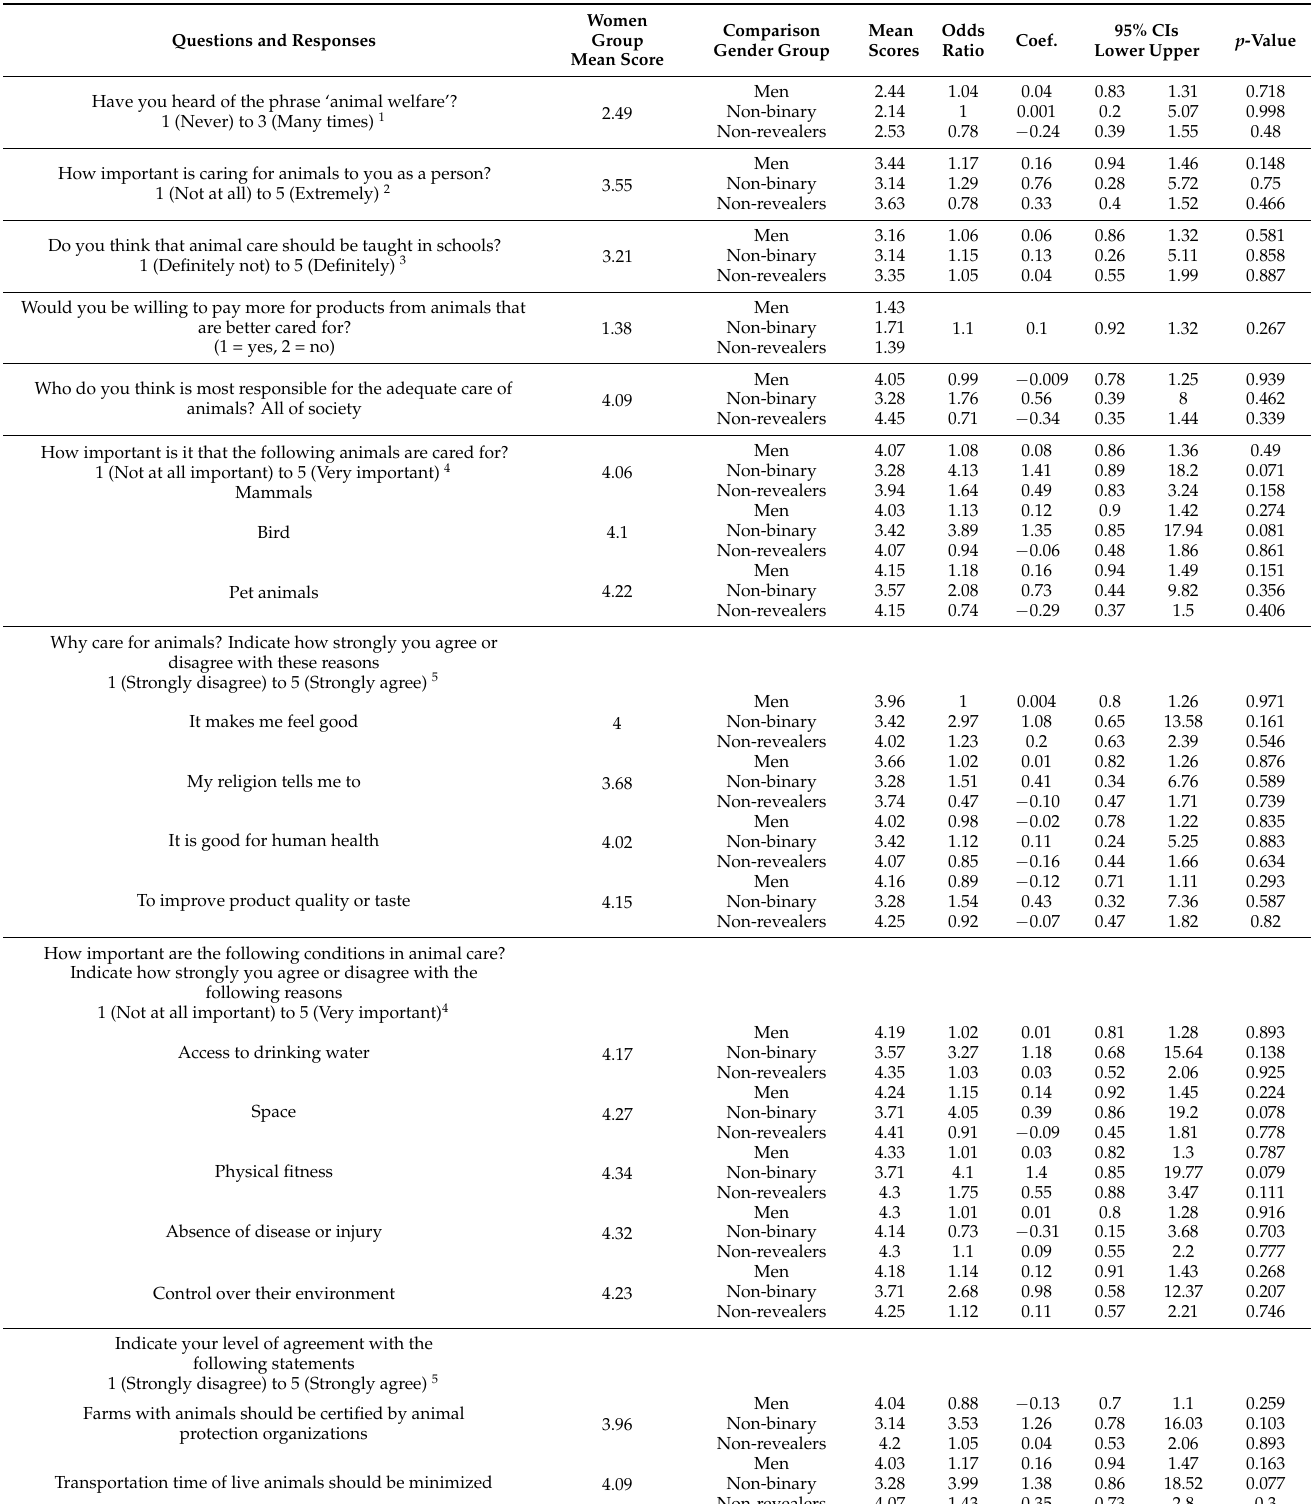
Table A1. Gender effects on respondents’ attitudes towards animal welfare in China. Mean responses on 5-point ordinal scales are provided. Non-significant results are presented between Men (n = 618), and Women (n = 628), Non-binary participants (n = 7) and Non-revealers (n =